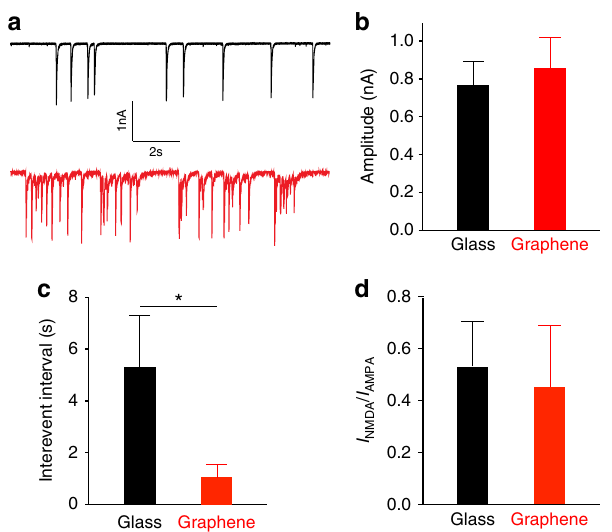
Fig. 5 Graphene increases spontaneous fi ring frequency in neurons. a Sample traces from neurons on glass (black) or graphene (red). b Mean sEPSC amplitudes ( n glass = 13 cells, n graphene = 15 cells, N > 4 batches; p > 0.1, two-tailed t -test, Cohen ’ s d = 0.10). c Mean sEPSC inter-event intervals ( n glass = 13 cells, n graphene = 15 cells, N > 4 batches, * p < 0.05, two-tailed t - test, Cohen ’ s d = 1.30). d I NMDAR / I AMPAR ( n glass = 10 cells, n graphene = 9 cells, N > 3 batches; p > 0.1, two-tailed t -test, Cohen ’ s d = 0.27). Error bars are